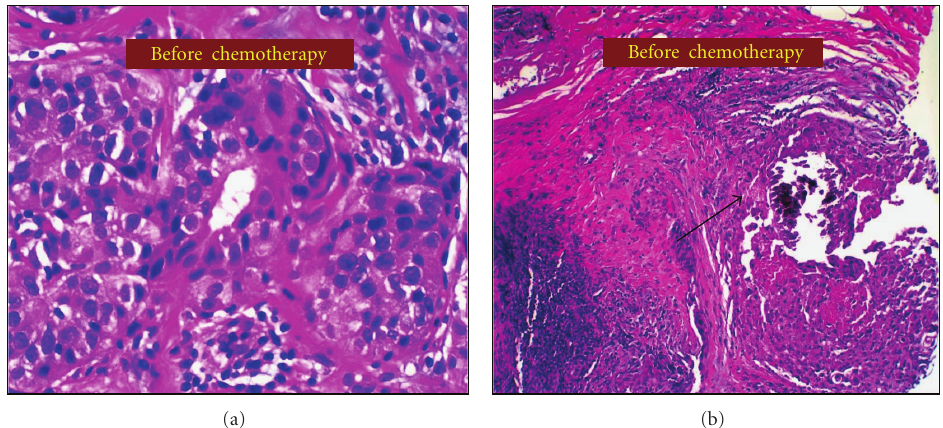
Figure 2: Pathologic findings from core needle biopsy before neoadjuvant chemotherapy. (a) H & E stain showing high-grade invasive carcinoma. (b) H & E stain demonstrating high-grade ductal carcinoma in situ associated with microcalcification (black arrow).